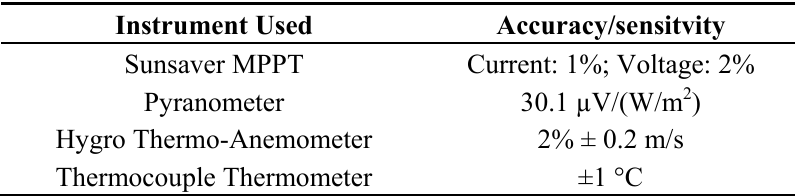
Table 4. Accuracy/sensitivity of the